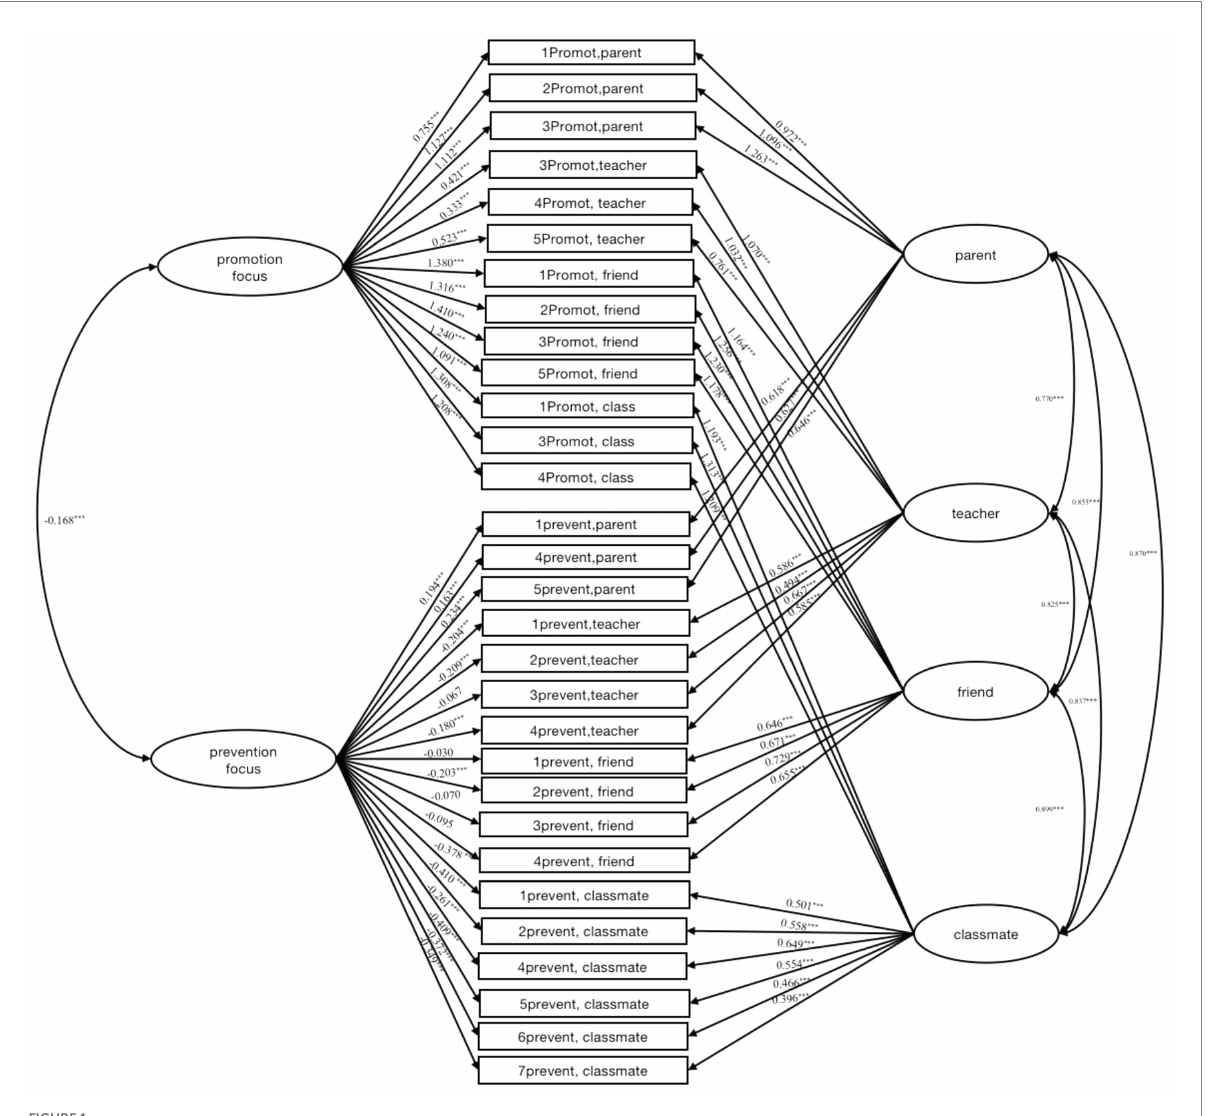
FIGURE 1 Multi-method, multi-trait analysis for the regular focus in relationships